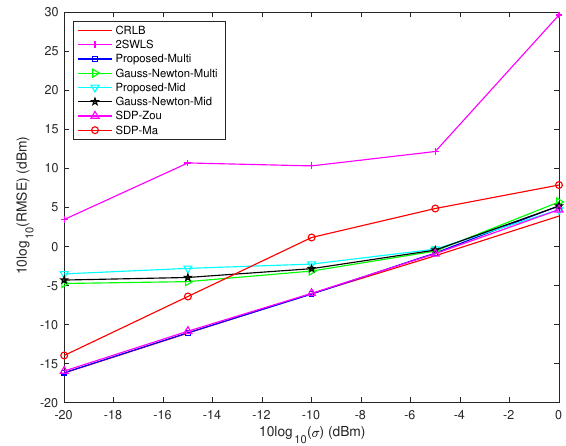
Figure 1. RMSE vs. σ in scenario